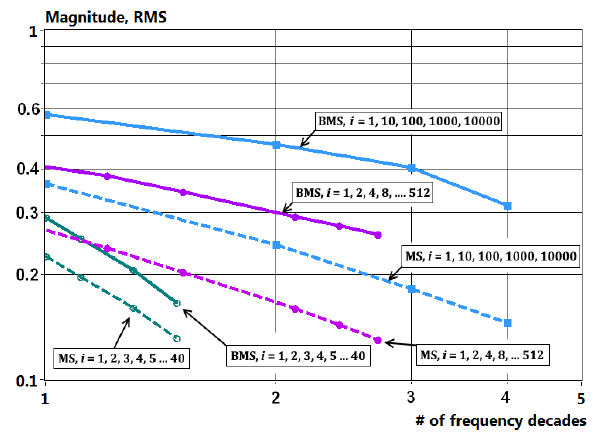
Fig.13: Normalized RMS magnitudes of consecutively and logarithmically distributed frequency components of optimized multisines (MS, dashed lines) and BMS (solid lines) vs. a number of frequency decades a signal